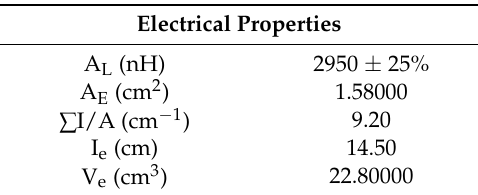
Table 2. Ferrite 77 toroid core electrical properties (courtesy: Fair-Rite products Corp).